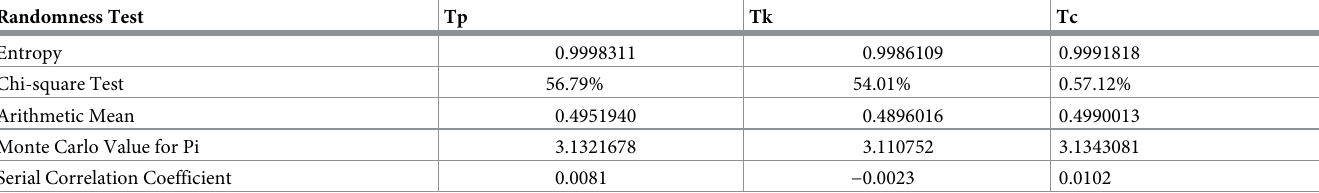
Table 7. Result of ENT test: Plaintext avalanche (Tp), Key avalanche (Tk), and Plaintext/Ciphertext correlation